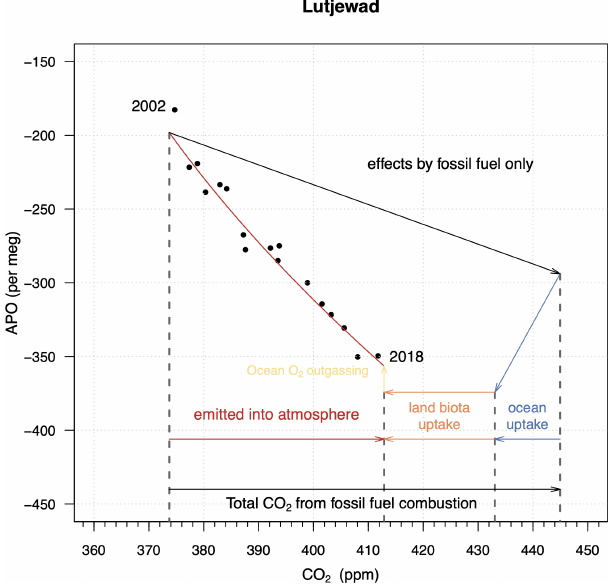
Figure 11. Vector diagram presenting the calculation of the global land biotic and oceanic carbon sinks for the 2002–2018 period. The black points are the annual averages of the measured APO and CO 2 values at Lutjewad, calculated from January to December of each calendar year. The black arrowed line represents the changes in the atmospheric APO and CO 2 values that would have occurred if all CO 2 emitted from fossil fuel combustion remained in the at- mosphere. The ocean uptake is presented by blue arrows and its slope is fixed to the APO / CO 2 molar ratio of 1.1 (which represents the removal of the biosphere signal in the definition of APO). The land biota uptake (orange) is a horizontal line, as APO does not in- clude a biosphere signal. The ocean O 2 outgassing effect is plotted in brown. The red line is a simple trend fitted through the